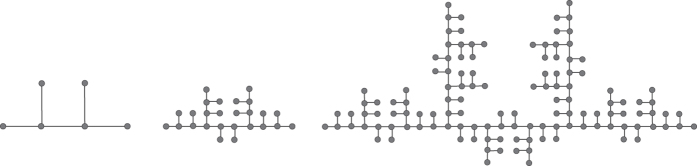
G1, G2, G3 of growing trees w.r.t. rule 1.